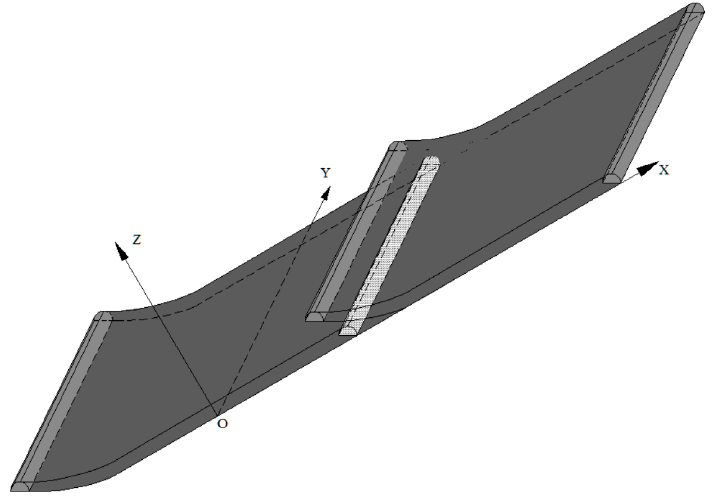
Figure 15. Sketch of a three-dimensional concept of the LMSG system.